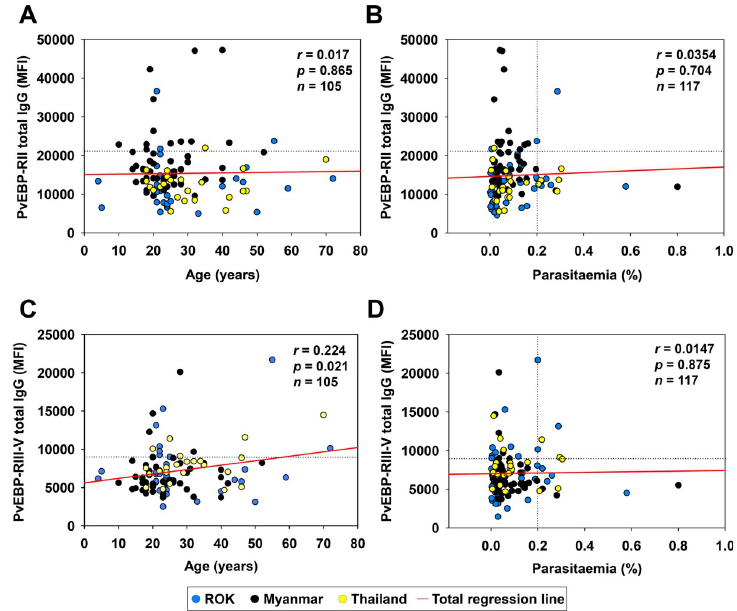
Fig 5. The correlation of parasitaemia and age with PvEBP domains. (A and B) PvEBP-RII and (C and D) PvEBP-RIII-V total IgG indices obtained from mean fluorescence intensity (MFI) were evaluated correlation with patient age (years) and parasitaemia (%) using Pearson correlation test ( r ), respectively. The horizontal dash line indicates MFI+2S.D. value as positive reactivity and vertical dash line in parasitaemia ( > 0.2) considered high